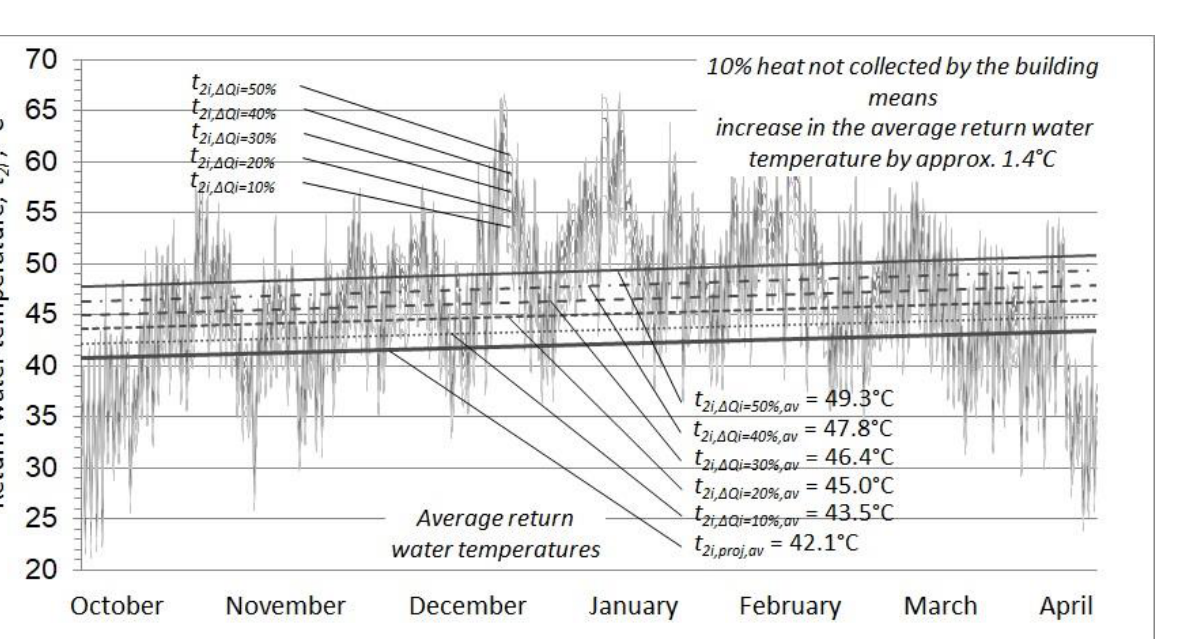
Figure 7 . Hourly frequency of occurrence of return water temperatures . By analyzing the frequency of return water temperatures in the system, it can be con- cluded that under reference conditions, the most common return temperatures range from 37 °C to 47 °C. Then, the frequency of return water temperatures was analyzed for relative characteristics in the range of the amount of heat uncollected by the building from 10% t 2 i ,10 % to 50% t 2 i ,50 % . For the amount of heat uncollected by the building, from 10% to 50%,